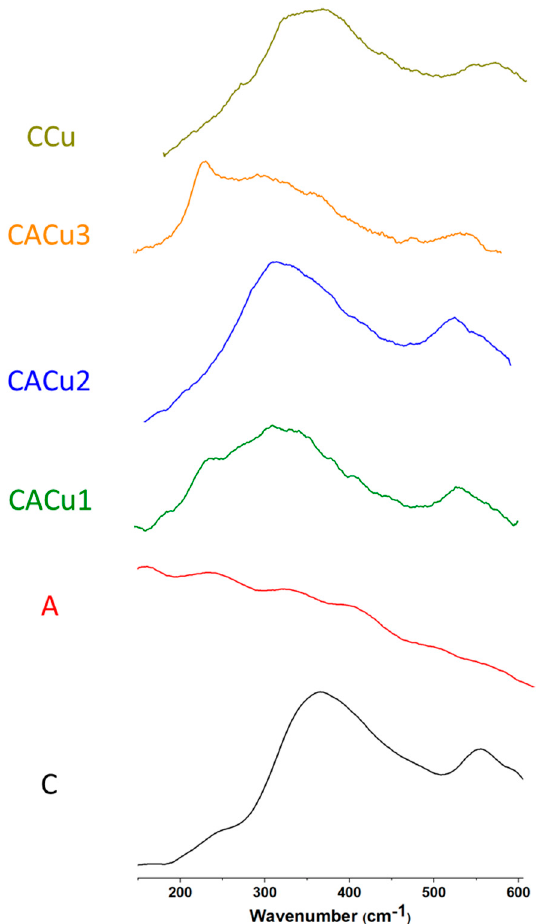
Figure 2. Raman spectra of the biopolymers (C, A), ternary composites (CACu1, CACu2, CACu3) and binary composite (CCu) materials.